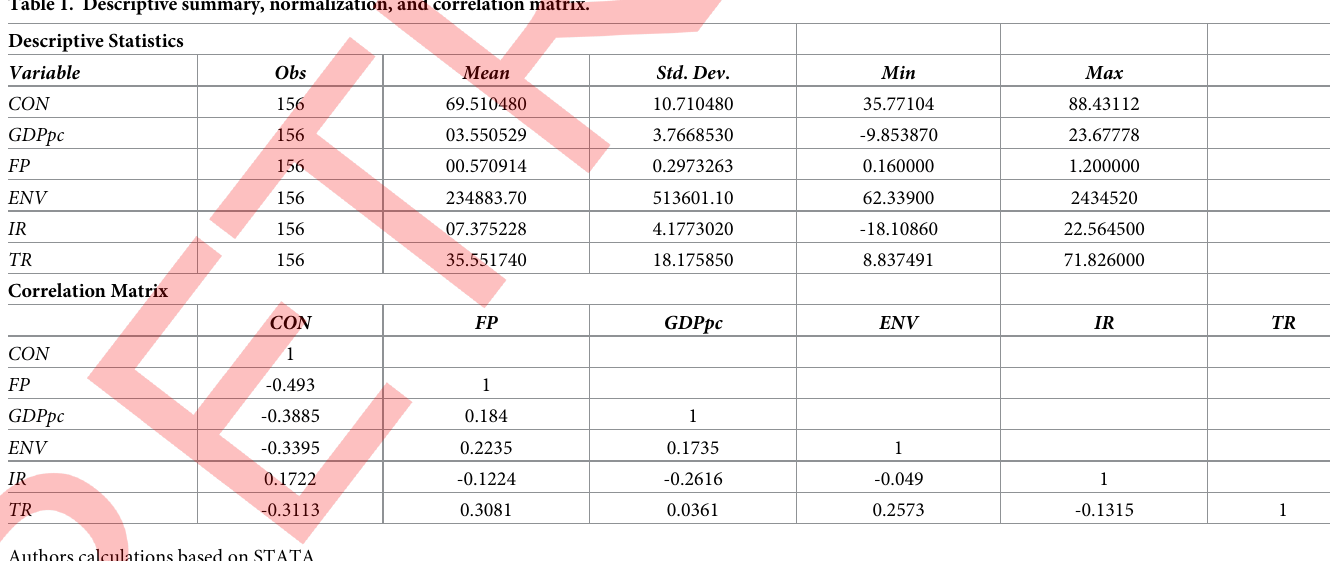
Table 1. Descriptive summary, normalization, and correlation